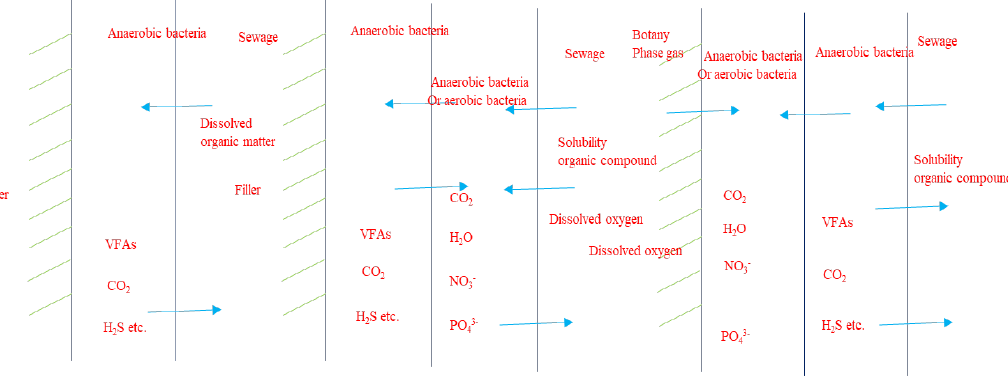
Figure 5. Schematic diagram of transfer and transformation of various substances in Constructed Wetland.